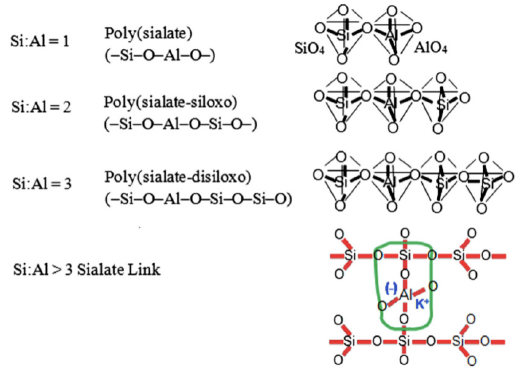
Figure 1. Chemical Reaction of Geopolymerisation [43].